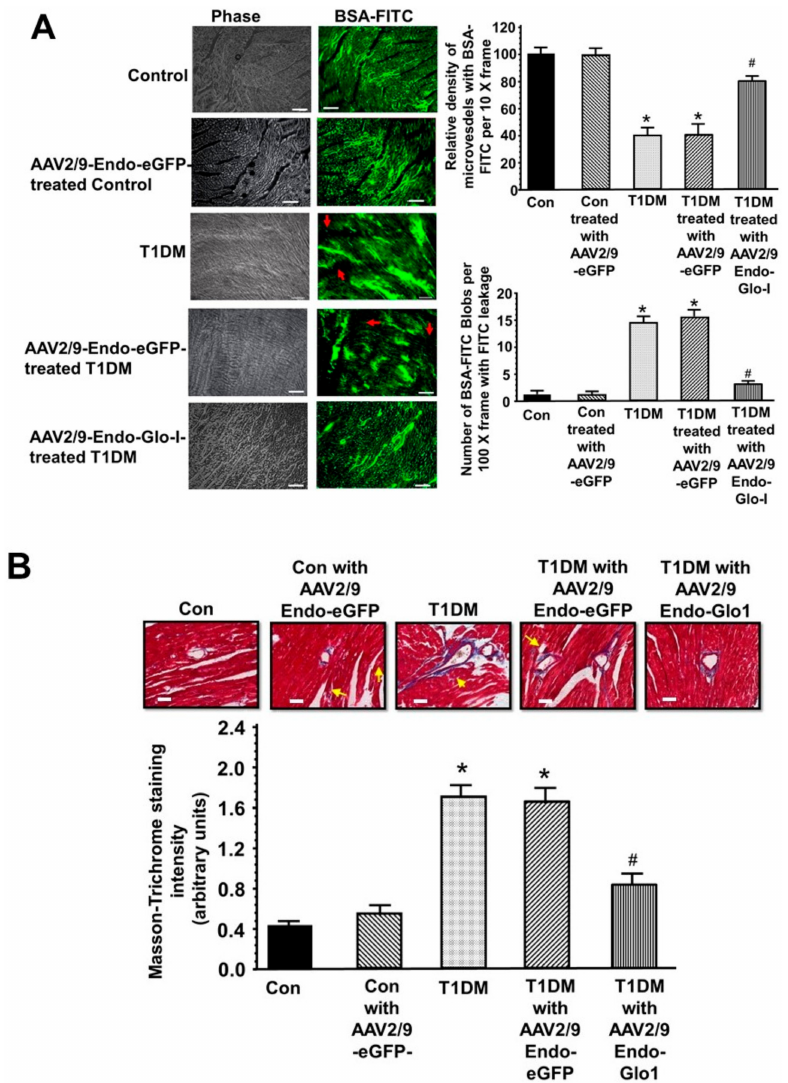
Figure 5. Vascular perfusion, permeability, and fibrosis in hearts from the control, T1DM, and T1DM-treated rats: ( A ) shows representative images of BSA-FITC in left ventricular tissues from the control, AAV2 / 9-Endo-eGFP treated control, T1DM, AAV2 / 9-Endo-eGFP-treated T1DM, and AAV2 / 9-Endo-Glo1-treated T1DM rats. Graphs on the upper right show the relative density of BSA-FITC per 10 × frame and in the lower left, the relative density of BSA-FITC blobs per 10 × frame (an index of vascular leakage). Values are mean ± S.E.M from n > 20 sections from n = 5–6 rats. White bar at bottom of each image = 50 µ m. ( B ), shows representative 10 × sections showing Masson Trichrome staining in left ventricular sections (apex) from control, AAV2 / 9-Endo-eGFP-treated Con, T1DM, AAV2 / 9-Endo-eGFP-treated T1DM and AAV2 / 9-Endo-Glo1-treated DM rats. Graph below is mean ± S.E.M from n > 20 sections from n = 4–5 male rats. * denote significantly di ff erent from the control ( p < 0.05), # denote significantly di ff erent from T1DM ( p < 0.05). White bar at bottom of each image = 50 µ